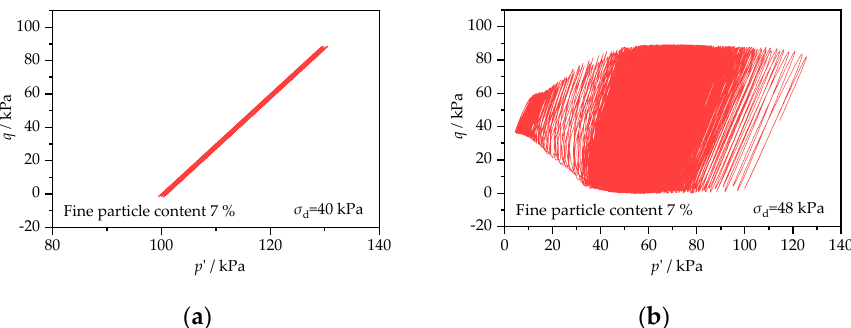
Figure 3. Stress path of the saturated silt with 7% fine particle content. ( a ) σ d = 40 kPa (Stable mode); ( b ) σ d = 48 kPa (Failure mode).